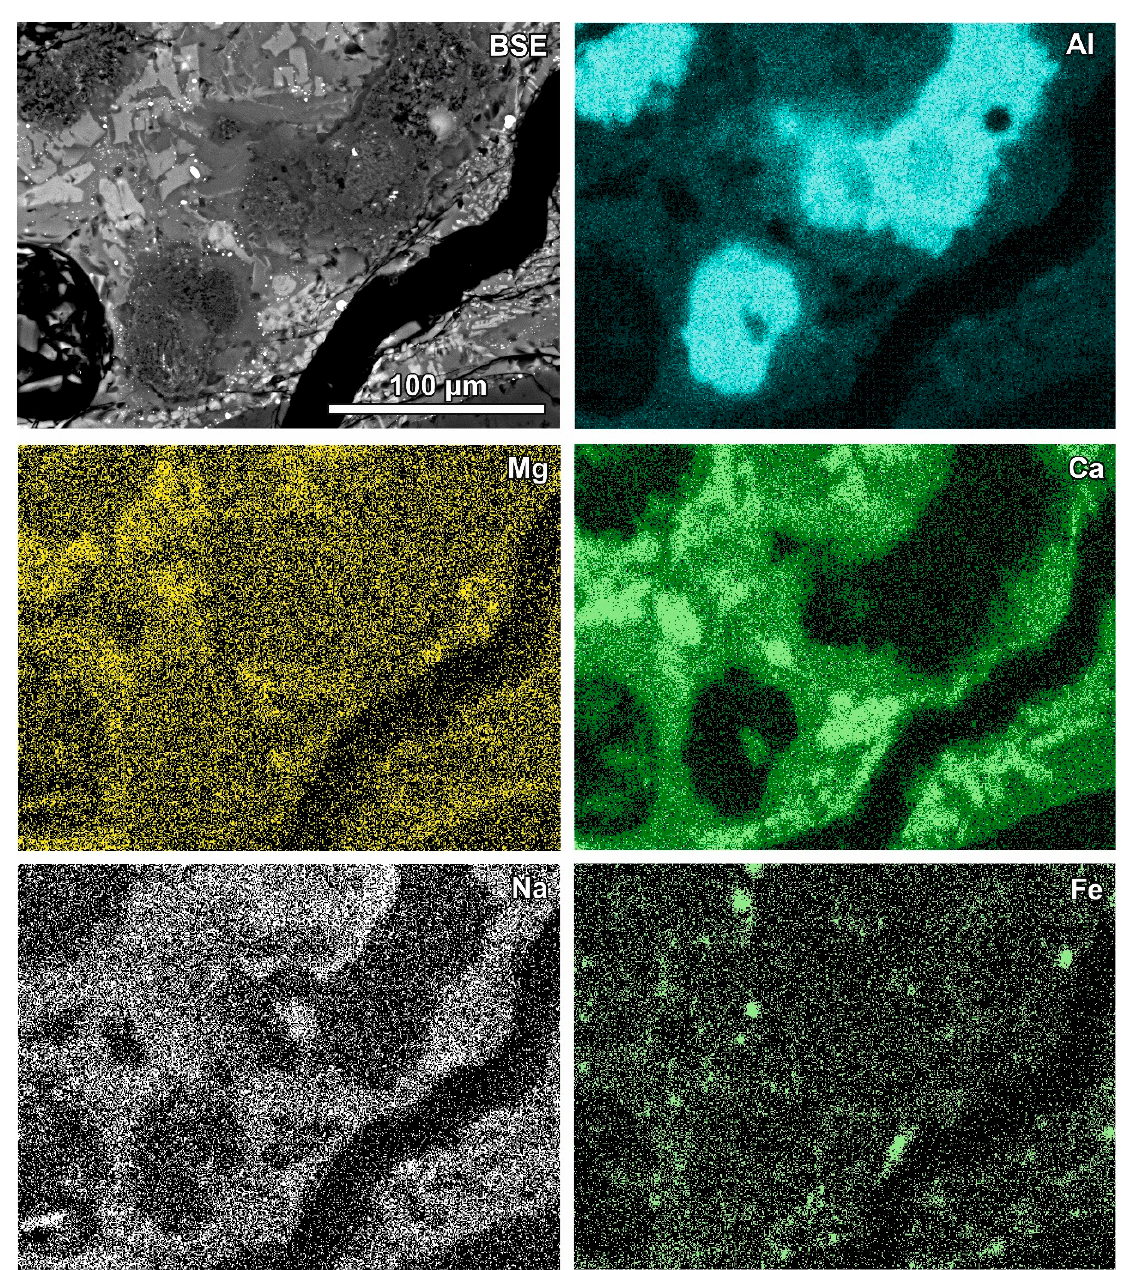
Figure 3. Al-rich irregular fragments (dark grey in the SEM BSE image) in glass rich in wollastonite- type crystals; BSE and selected elements’ distribution images (sample RZ10).